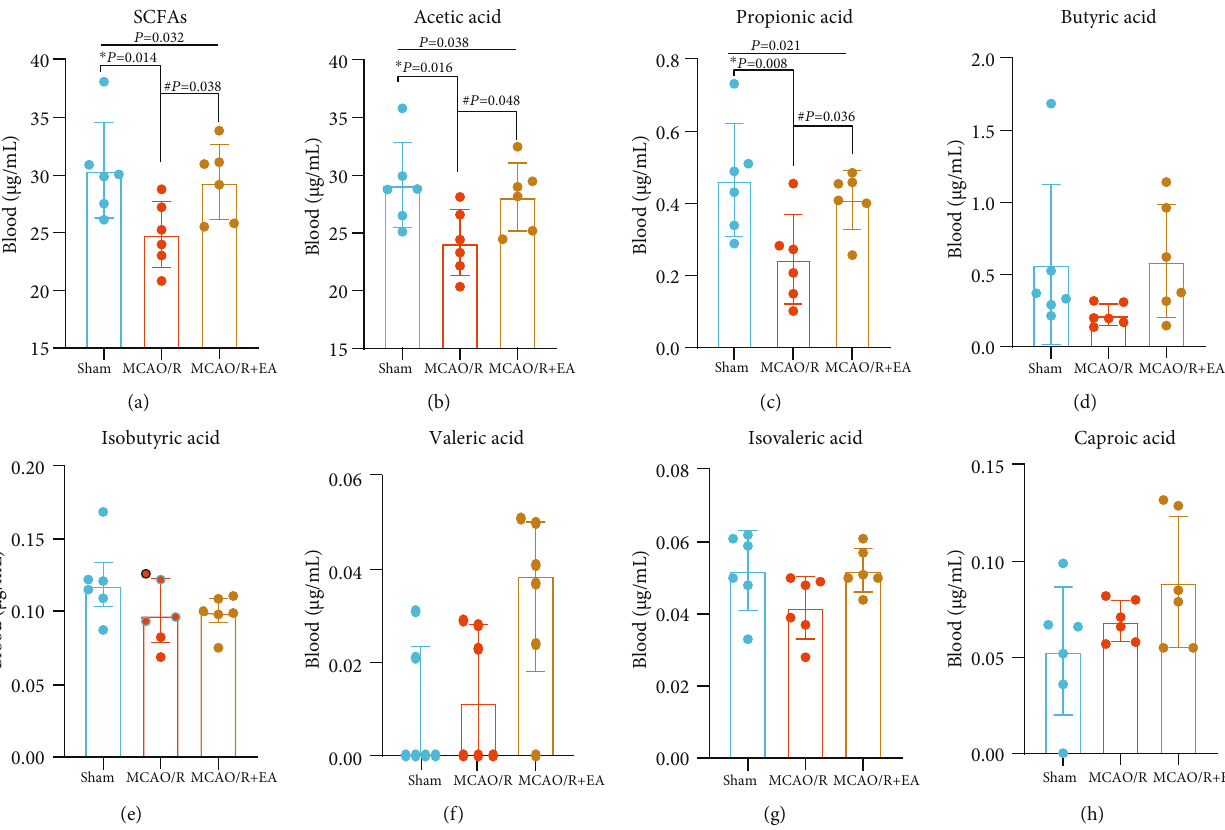
Figure 7: Concentrations of SCFAs in the peripheral blood of the sham group, MCAO/R group, and MCAO/R+ EA group. The data (a – d, g, and h) are presented as the mean ± standard deviation, and the data (e and f) are presented as the median ± quartile , n = 6 . One-way analysis of variance (a – d, g, and h) and the Kruskal – Wallis test (e and f) were used. Abbreviations: EA: electroacupuncture; MCAO/R: middle cerebral artery